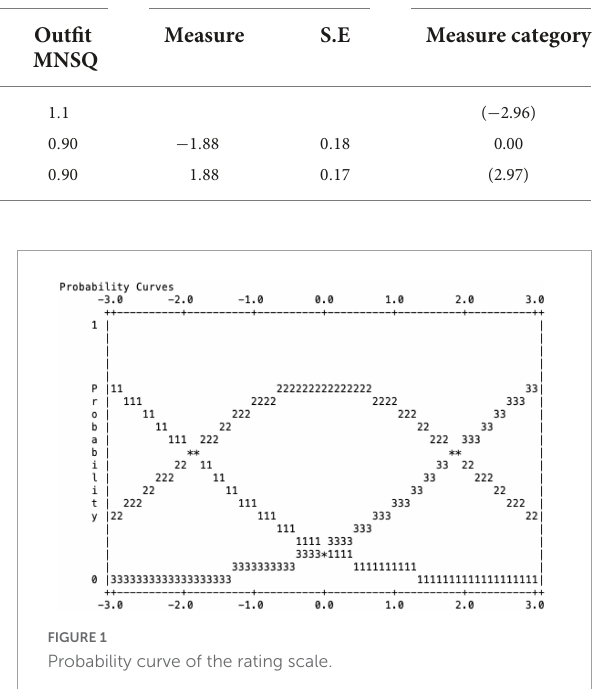
FIGURE1 Probability curve of the rating